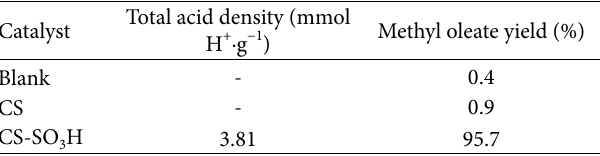
Table 2: The methyl oleate yield comparison different catalysts.